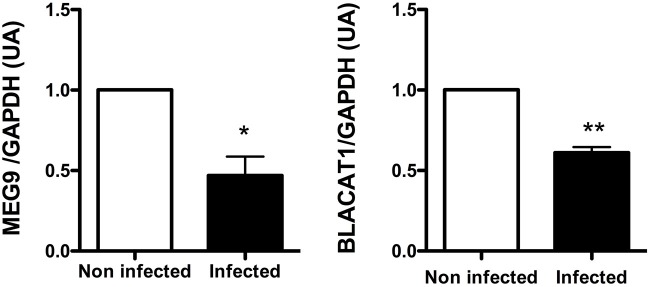
Validation by qRT-PCR of BLACAT1 and MEG9 expressions in bronchial primary epithelial CF cells infected with Pa. RNA were purified in CF cells collected from 4 different patients and infected with Pa. LncRNA levels were measured at 0 (white bar) and 2 h (black bar) post-infection for MEG9 and 0 (white bar) and 6 h (black bar) post-infection for BLACAT1. The statistical analysis consisted in a paired t-test. *P < 0.05 and **P < 0.001.